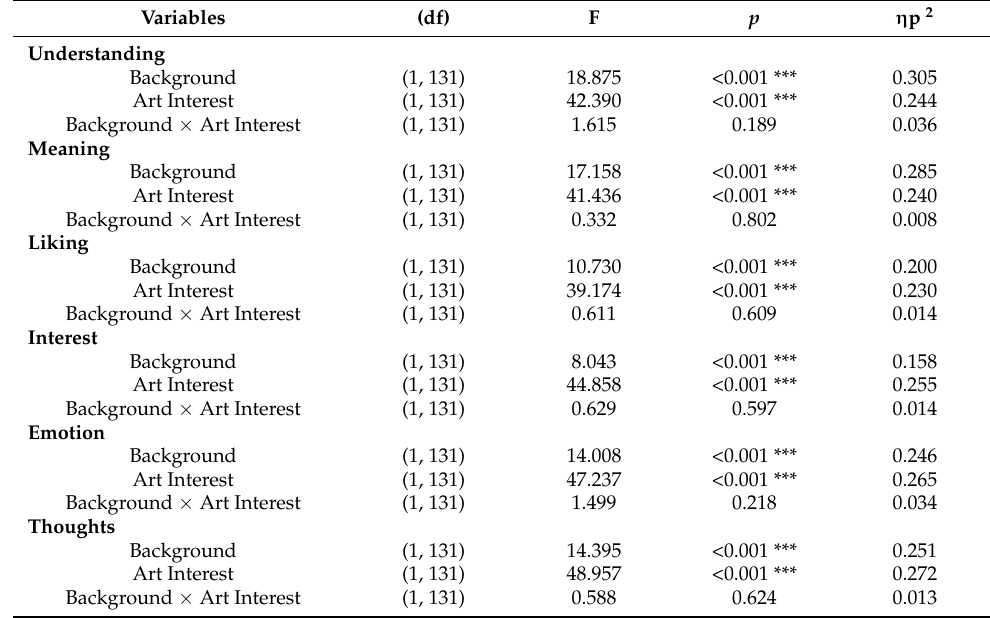
Table 9. Results of two-way repeated measures